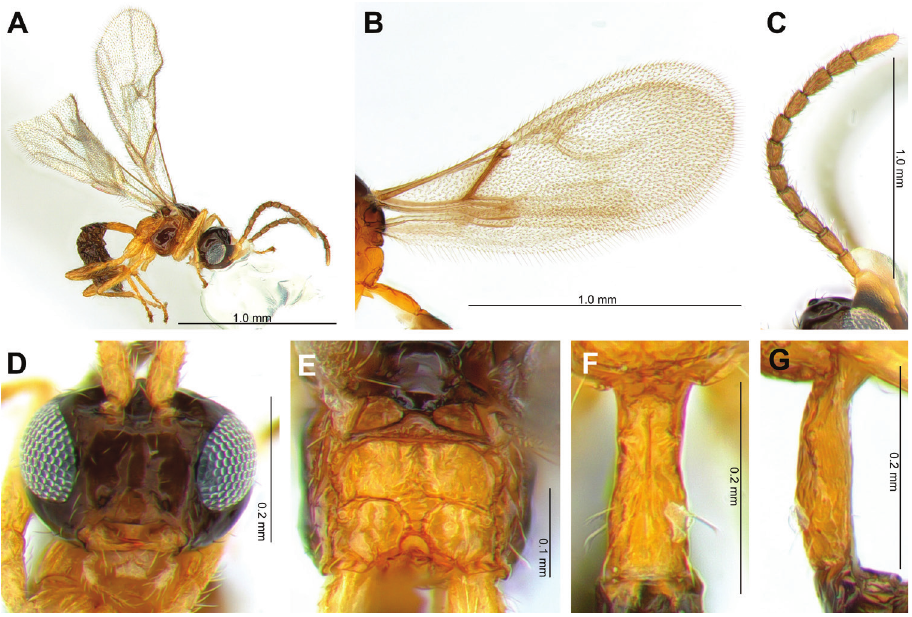
Figure 4. Aphidius asiaticus Kim & Tomanović, sp. nov., female A body B wing C antennae D head E propodeum F dorsal view of petiole G lateral view of